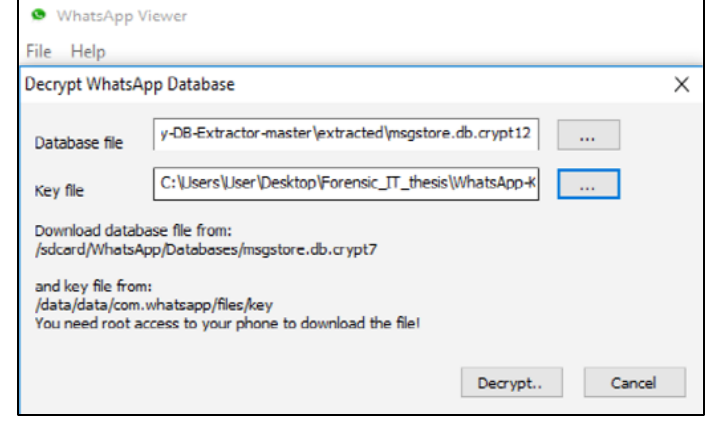
Figure 5. WhatsApp viewer tool